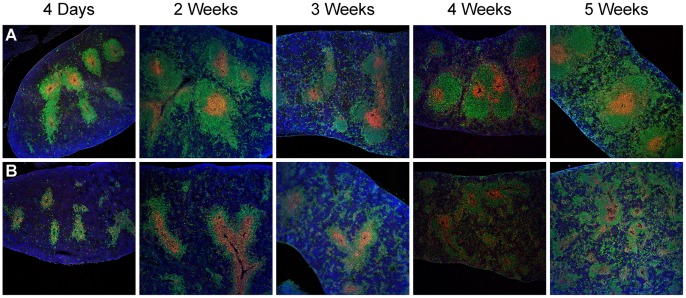
Comparison of splenic white pulp in Sharpincpdm mutant and control mice.The white pulp of control (A) mice is discrete and well-organized. B and T cell regions of the Sharpincpdm mutant (B) spleen are smaller, organization is poor, and splenomegaly is common (10×). Images represent at least 3 mice per group examined at each time point. Green–B220+ B cells, Red–CD3+ T cells, Blue–DAPI (nuclear) counterstain. IFA.